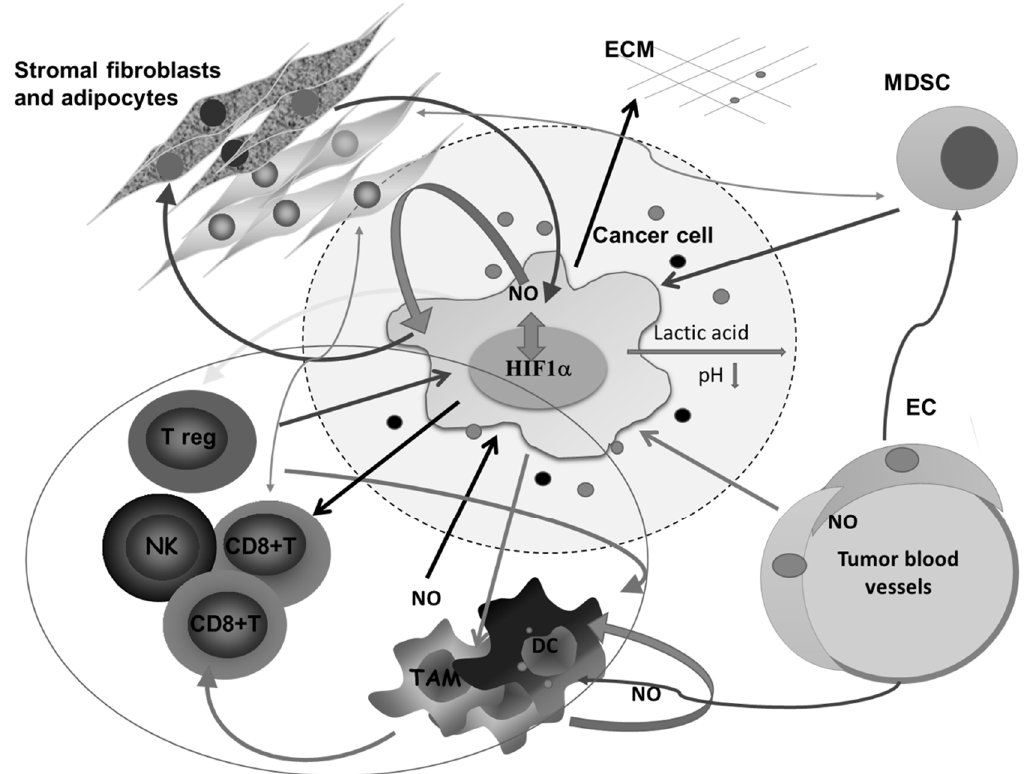
Figure 2. Complex intercellular communication between tumor cells and other members of the microenvironment in a solid tumor. O 2 deficiency due to the compromised blood supply provokes the expression of HIF1α- and HIF1α-related genes involved in regulating the synthesis of nitric oxide (NO), glycolysis, and angiogenesis, and remodeling of the extracellular matrix. Lactic acid accumulation decreases pH in the surrounding area. Additionally, together with different molecules secreted by tumor cells, lactic acid affects macrophages (Mfs), dendritic cells (DCs), and cytotoxic lymphocytes, and potentiates accumulation of regulatory T cells (Tregs) and myeloid-derived suppressor cells (MDSCs). Tumor-associated macrophages (TAMs) express several M2-associated protumor functions, including promotion of angiogenesis, further matrix remodeling, and suppression of adaptive immunity. Stromal adipocytes and tumor cells have a symbiotic relationship mediated by NO. Cytotoxic lymphocytes, as well as MDSCs, in the absence of glucose supply, obtain energy from lipid storage by communicating with adipocytes. ECM—extracellular matrix, NK— natural killer cells, EC—endothelial cells.